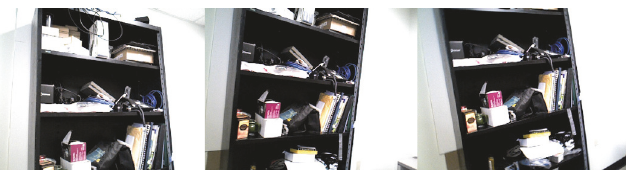
Figure 1: Examples of images taken from a moving camera from the same class. A pair of these would be classified under the category